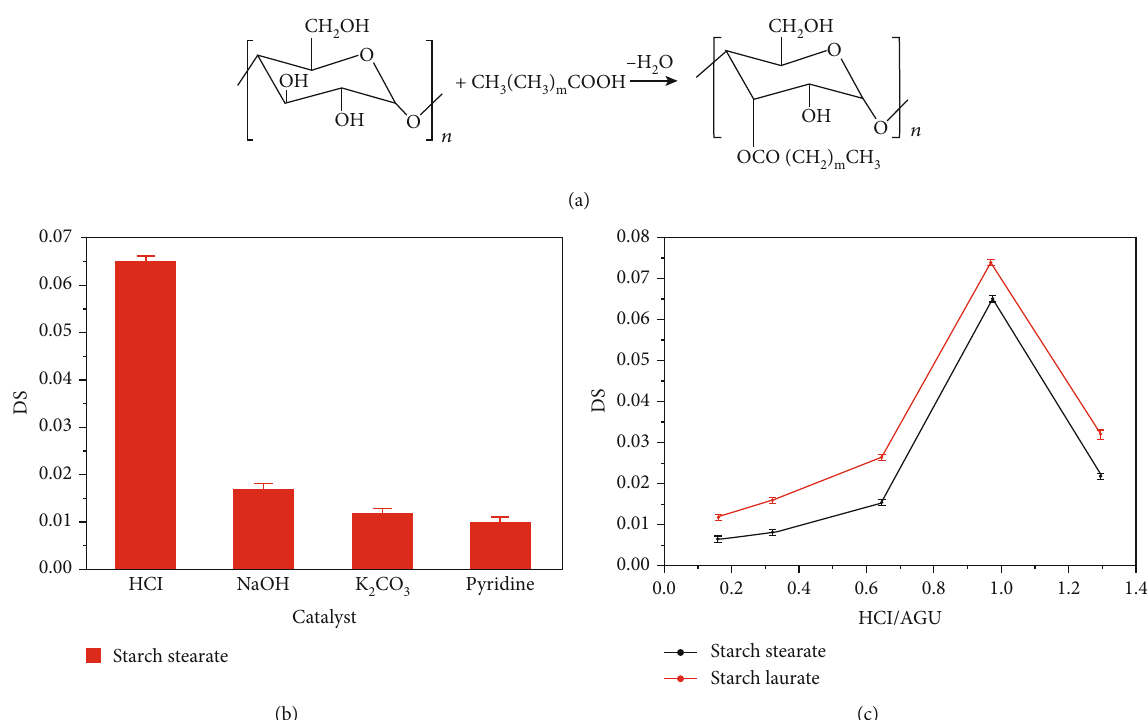
Figure 6: Starch esteri fi cation by saturated alkyl carboxylic acid (a) and e ff ect of the catalyst on the degree of substitution of starch stearate (b) and HCl dose (c)